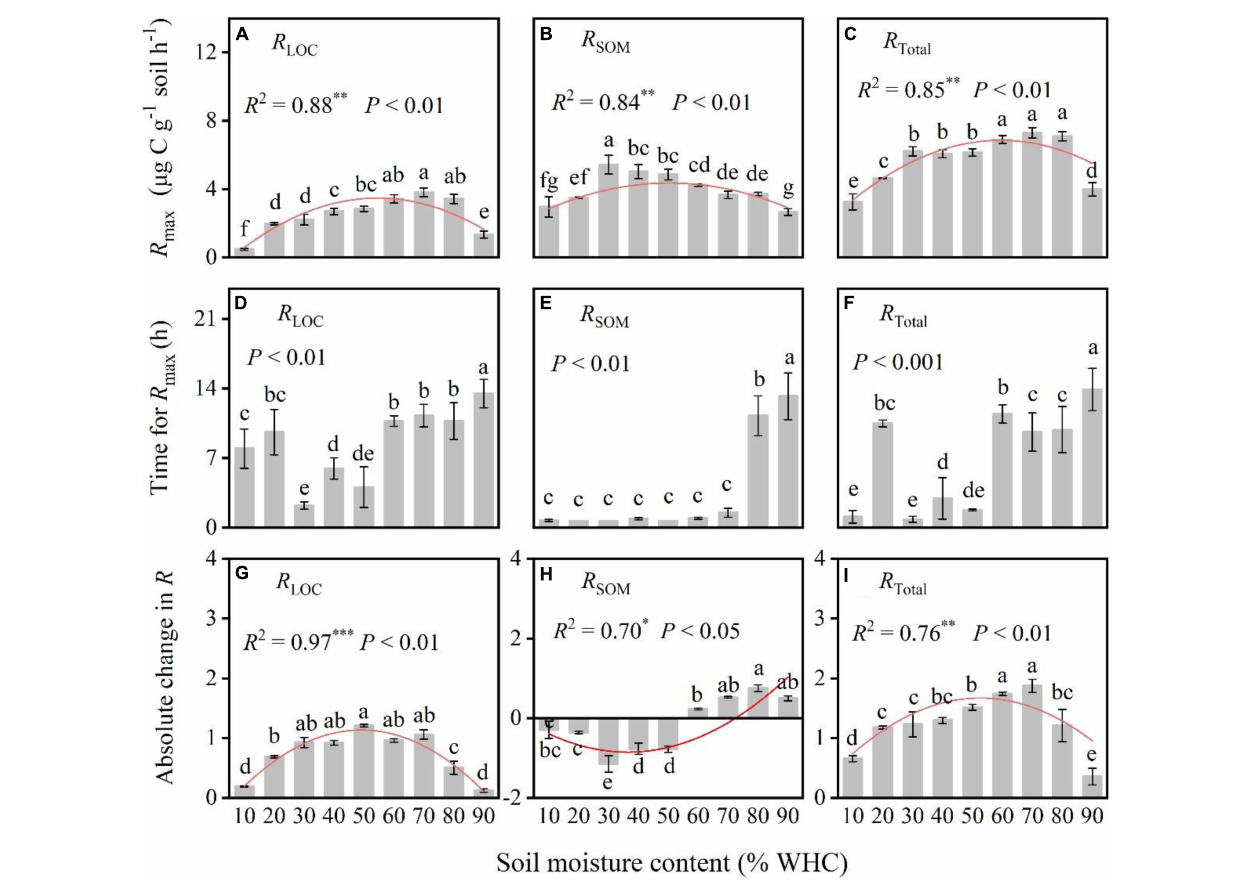
FIGURE 3 | Comparison of the max microbial respiration rate ( R max ), time for R max , and absolute change in respiration rate under different soil moisture treatments. (A–C) The relationships between soil moisture content and max respiration rate. (D–F) The relationships between soil moisture content and the time taken to reach R max . (G–I) The relationships between soil moisture content and the absolute changes in respiration. P -values and different letters indicate significant differences among the different soil moisture content treatments ( n = 3, mean ± SE). Red lines indicate the fitted curves of the corresponding parameters vs. soil moisture content. R 2 and * denote the goodness of fit and significance level, and the *, **, and *** in the figures indicate statistical difference levels of P < 0.05, P < 0.01, and P < 0.001,